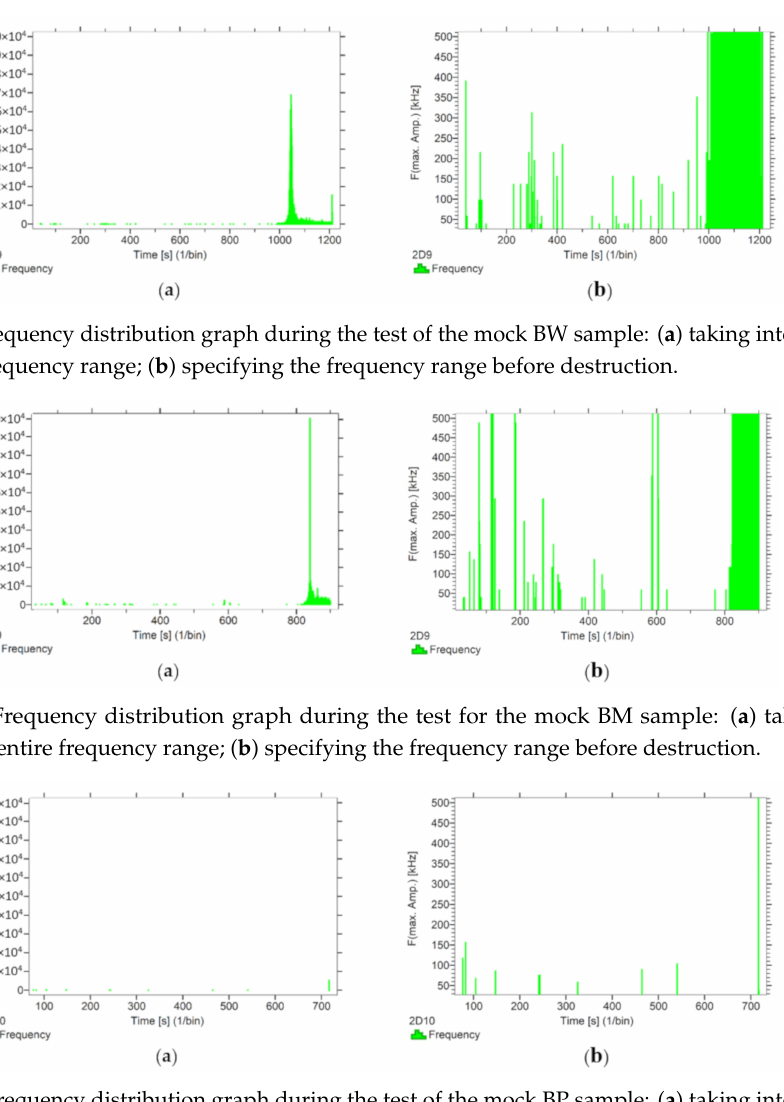
Figure 11. Frequency distribution graph during the test of the mock BP sample: ( a ) taking into account the entire frequency range; ( b ) specifying the frequency range before destruction.